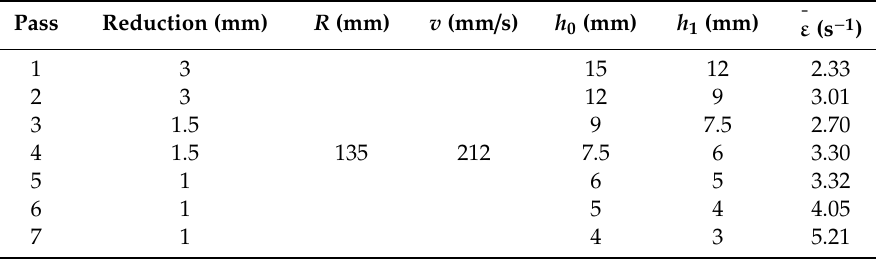
Table 2. Parameters for DRTMT and